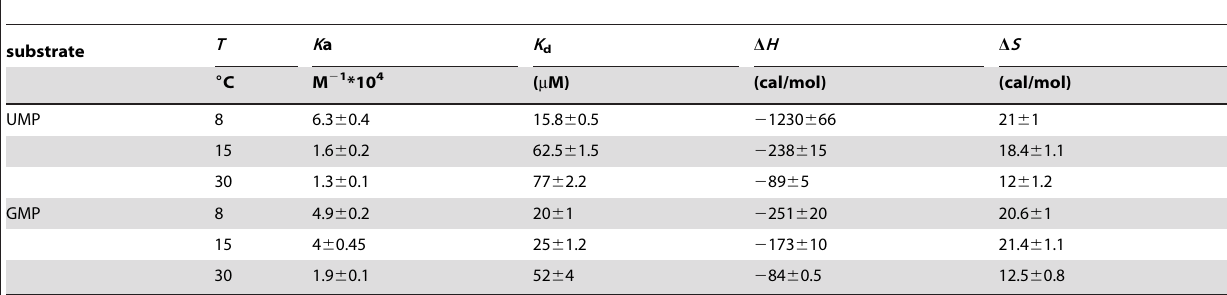
Table 4. The thermodynamic constants obtained by isothermal titration calorimetry for the association of nucleosides with Ago2PAZ